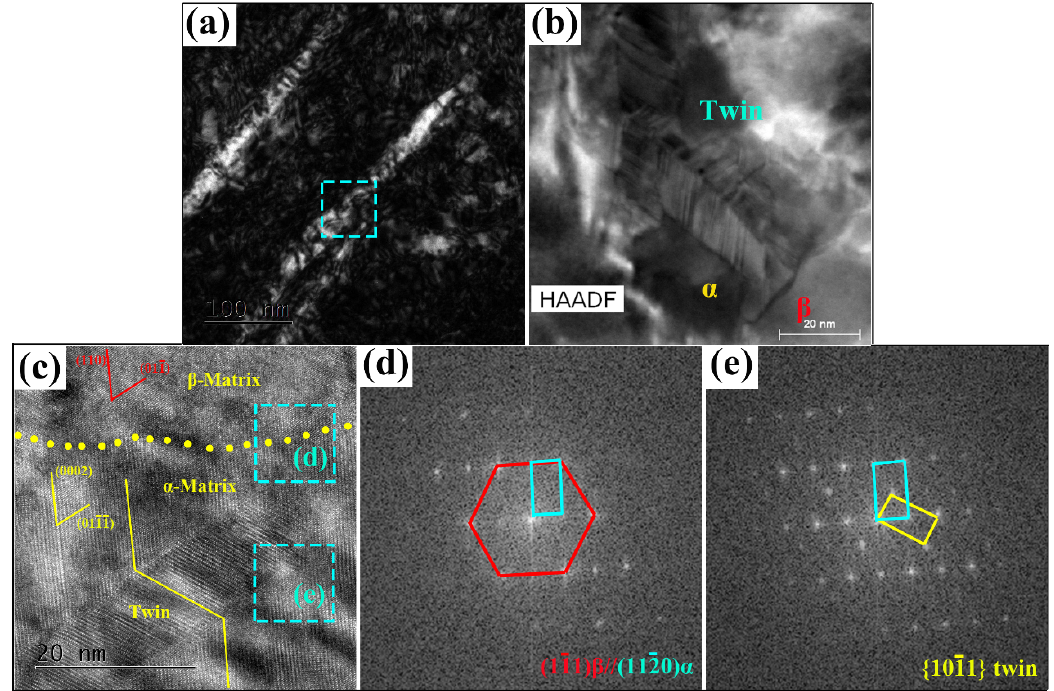
Figure 11. ( a ) TEM image of the sample 80% + aging. ( b ) Aberration-corrected HAADF images and ( c ) HRTEM image showing the formation of α-twin bands in the α lath. The corresponding FFT patterns revealing: ( d ) the BOR between the α and β phases, and ( e ) a α observed in the α lath.